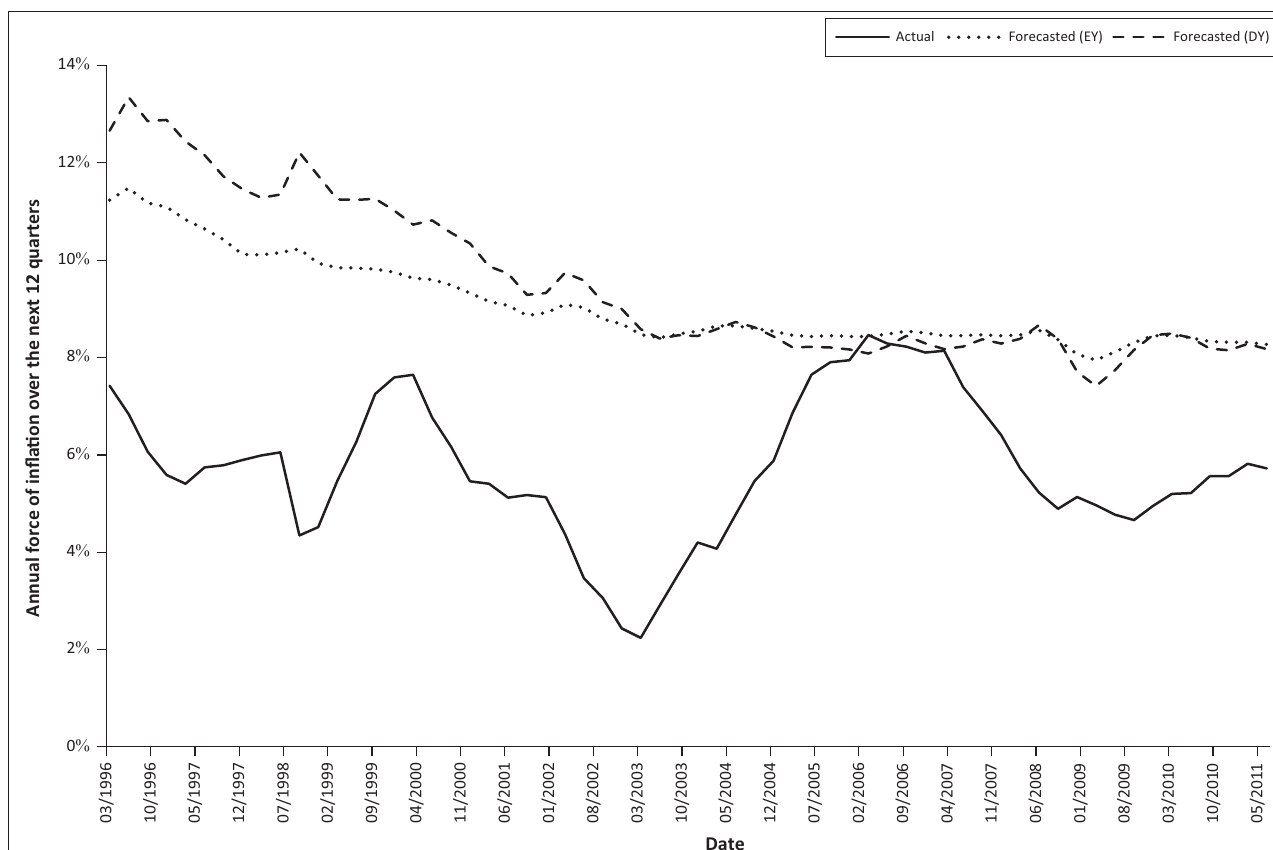
FIGURE 3: Plot of annual forces of inflation over a 12 quarter ahead